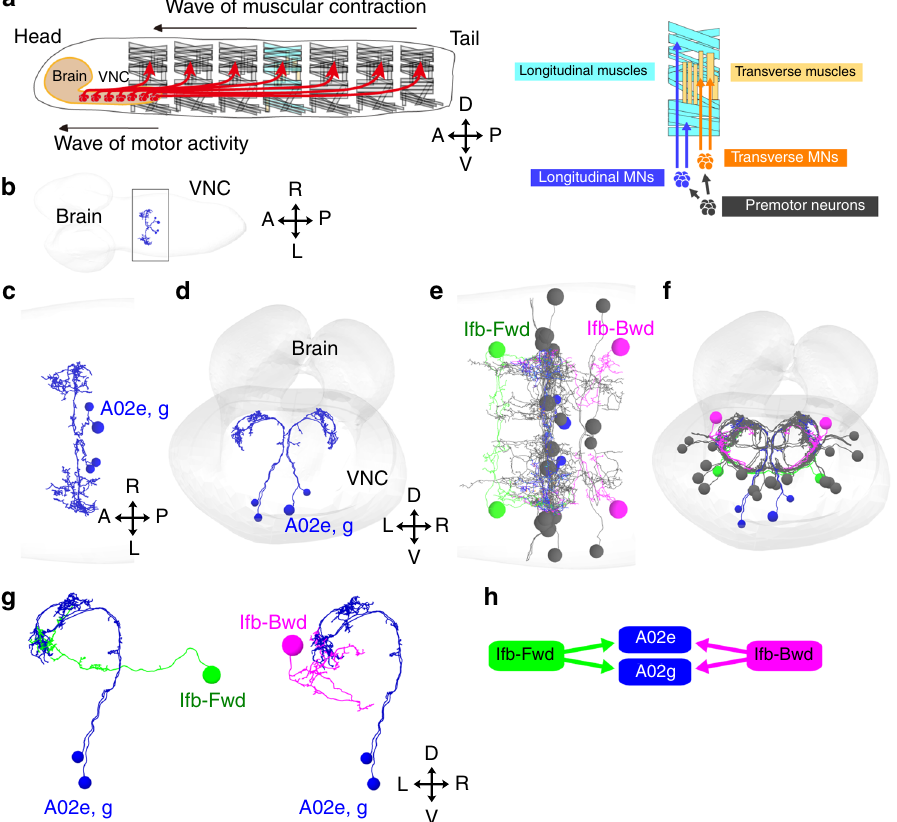
Fig. 1 Identi fi cation of 2nd order premotor interneurons. Circuit mapping of PMSIs, A02e and A02g and their presynaptic partners from EM. a (Left) Schematic of larval muscles and the nervous system. Crawling behavior is generated by the propagation of muscular contraction along the length of the body, which is operated by the propagation neural activity within the central nervous system (VNC: ventral nerve cord). (Right) The body wall muscles are classi fi ed as longitudinal and transverse muscles by their orientations. They are innervated by distinct motor neurons, Longitudinal motor neurons (MNs), and Transverse MNs. b An image of the entire CNS reconstructed by electron microscopy. The black box indicates the region shown in ( c ). c , d Dorsal ( c ) and posterior ( d ) views of A02e and A02g (blue) in segment A1. Gray shading represents the outline of the nervous system. e , f Dorsal ( e ) and